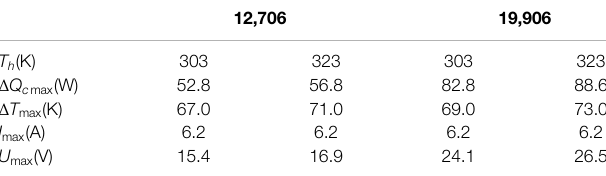
TABLE 2 | The parameters of Two kinds of thermoelectric cooling